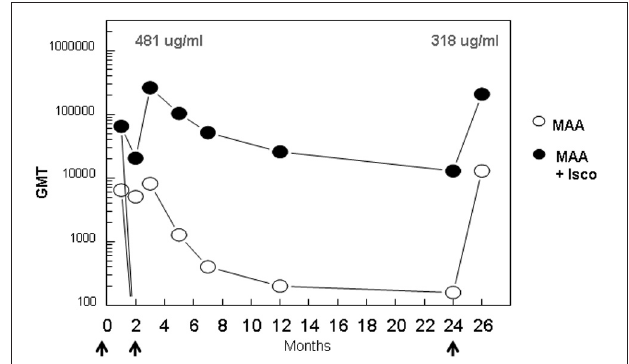
FIGURE 6 | Kinetics of anti-repeat antibody response in rhesus macaques. Groups of three adult rhesus macaques were immunized with (NANP) 6 -OMPC/MAA with or without Iscomatrix® on days 0, 70, and 732 (arrows). Sera were collected at indicated time points and results are shown as ELISA GMT using (NANP) 3 peptide coated plates. The concentration of repeat specific antibody ( µ g/ml) is shown for peak responses post 1st and 2nd booster